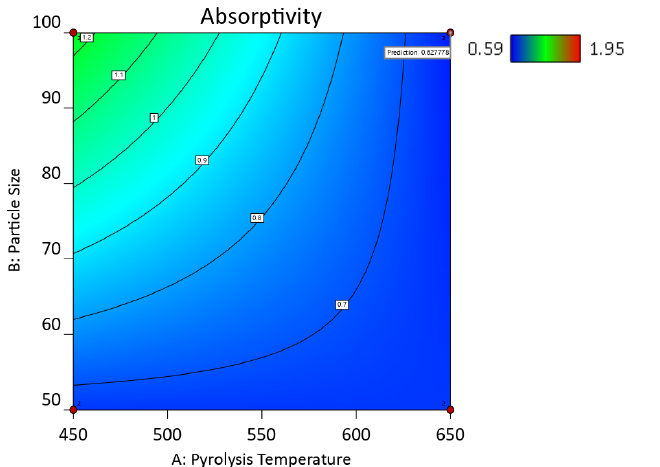
Figure 19. Contour plot of the desirability of 0.972 with the predictability of 0.697 for the water absorptivity of switchgrass biocarbon-filled hemp-reinforced polymer composites when the filler loading is 20%.